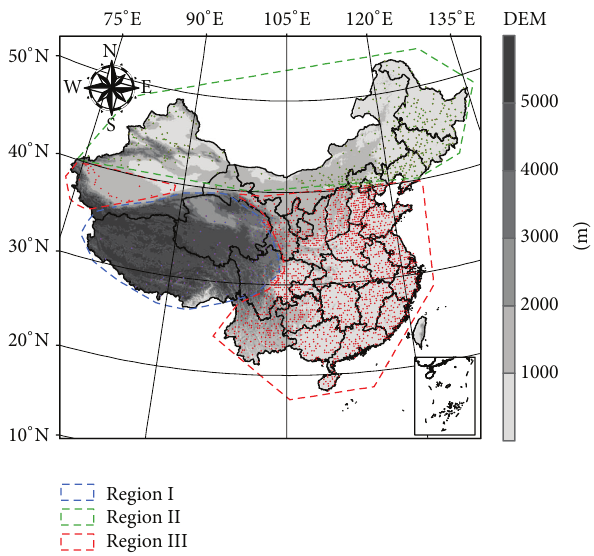
Figure 1: Distribution of grid boxes that contain at least one rain gauge and DEM. Blue points represent gauges located at high altitude regions (Region I) with elevation above 3000 m. Green points represent gauges located at north of 40 ∘ (Region II). Red points represent gauges located at lowland and low latitude regions (Region